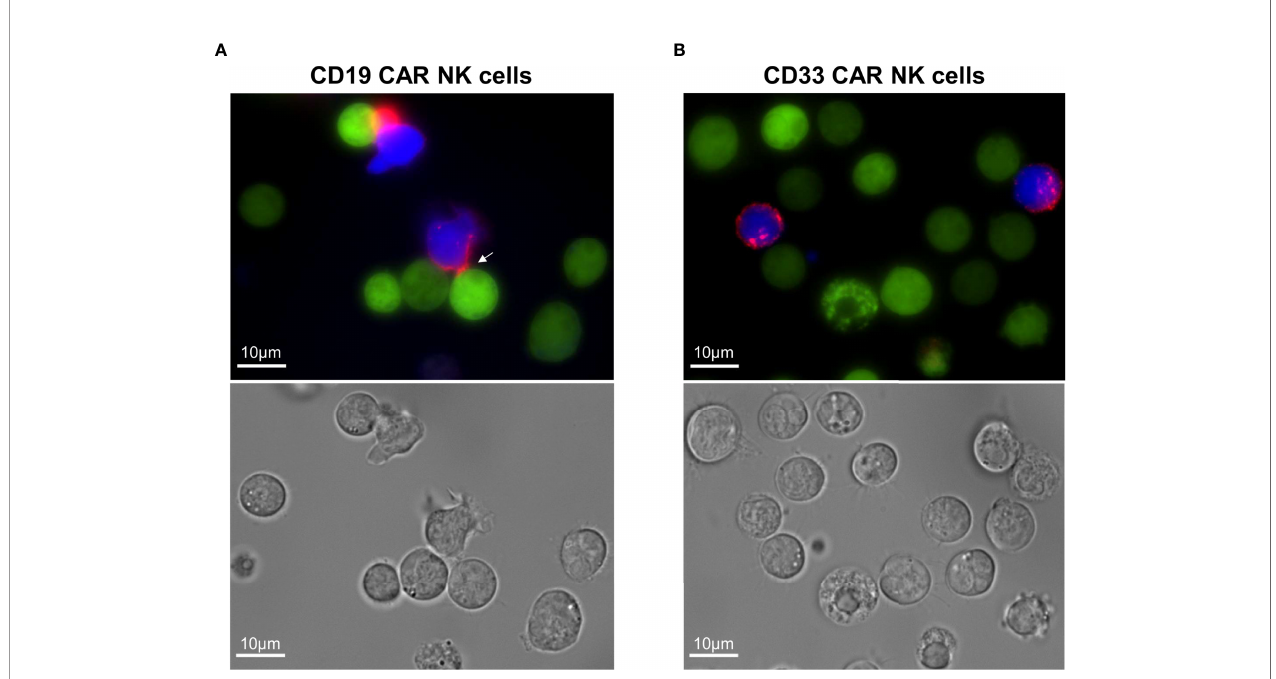
FIGURE 5 | Visualization of the immunological synapses formed between CD19 CAR NK cells and CD19+ REH cells. (A) The immunological synapse between CD19 CAR NK cells and CD19+ REH cells was analyzed by fl uorescence microscopy, visualizing the CAR expression (CD34-PE-conjugated antibody, red) on MACS-enriched CAR NK cells (BFP expression, blue) in relation to REH cells (EGFP expression, green). (B) MACS-enriched CD33 CAR NK cells served as negative controls. Contrast settings are uniform for both images for the channels: bright fi eld, 377/447 and 470/525 nm. The contrast in channel 545/620 nm was adjusted to maximize the visibility of the cell-to-cell